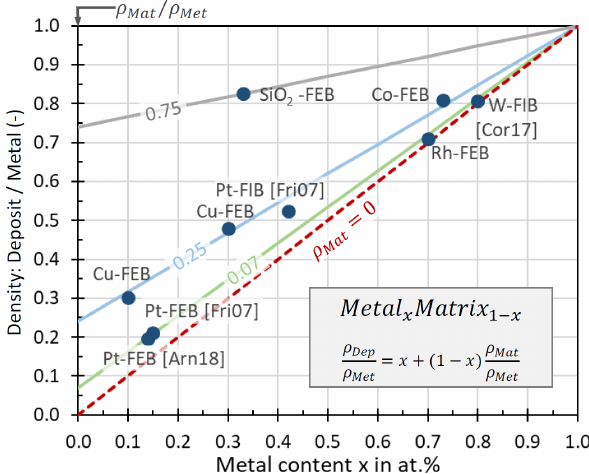
Figure 23. Normalized density of FEBID and FIBID material vs. reported metal content. The lines were obtained from Equation (18) normalizing to the metal density (see inset). Numerical values refer to the corresponding ρ Mat / ρ Met ratios; the metal is shown in the data point legends.